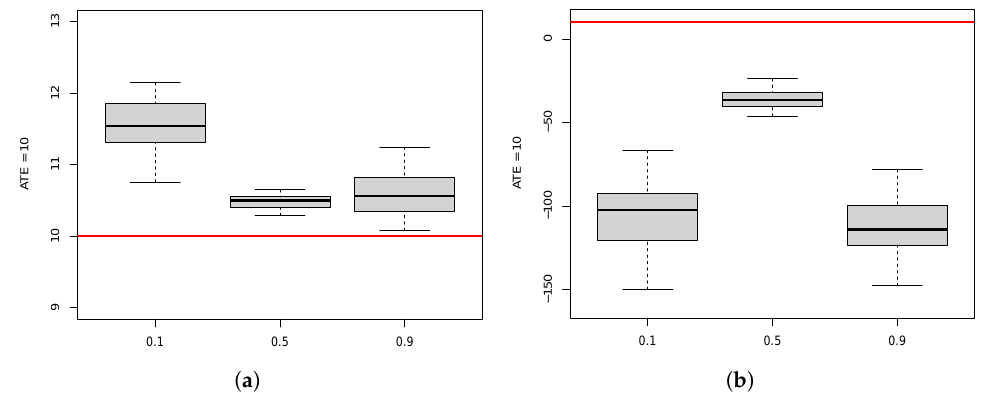
Figure 9. ATE true = 10 estimations for different participation rates for X-Learner Lasso method. Note that the scales of the two figures are not the same. ( a ) X-Learner Lasso: linear. ( b ) X-Learner Lasso: